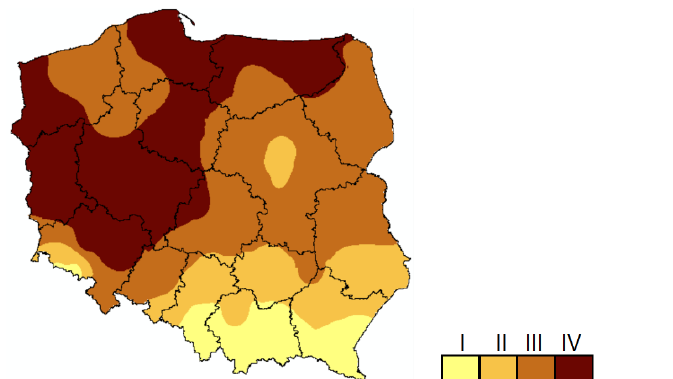
Figure 14. The zones of risk and variability of spring (from March to May) precipitation deficits in Poland. Years 1951 – 2018.